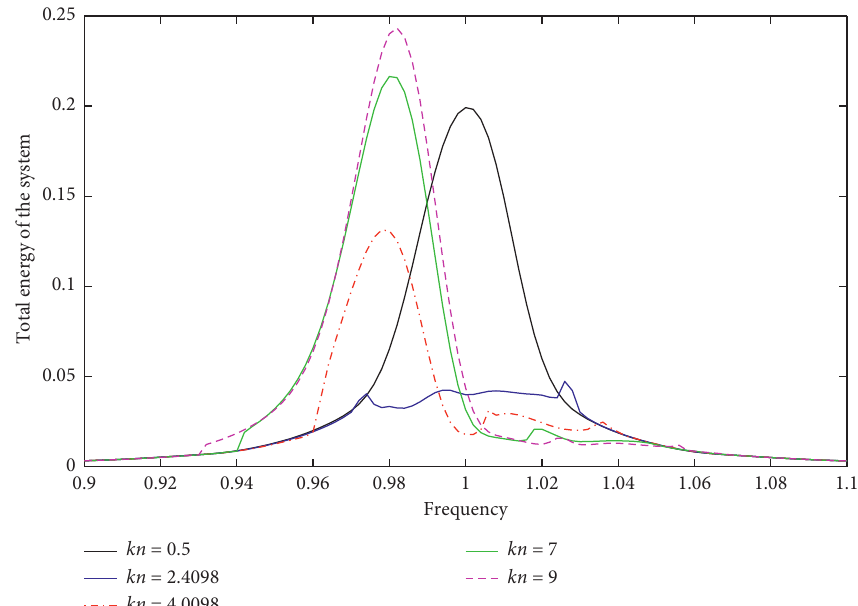
Figure 24: Average total energy of the system with respect to excitation